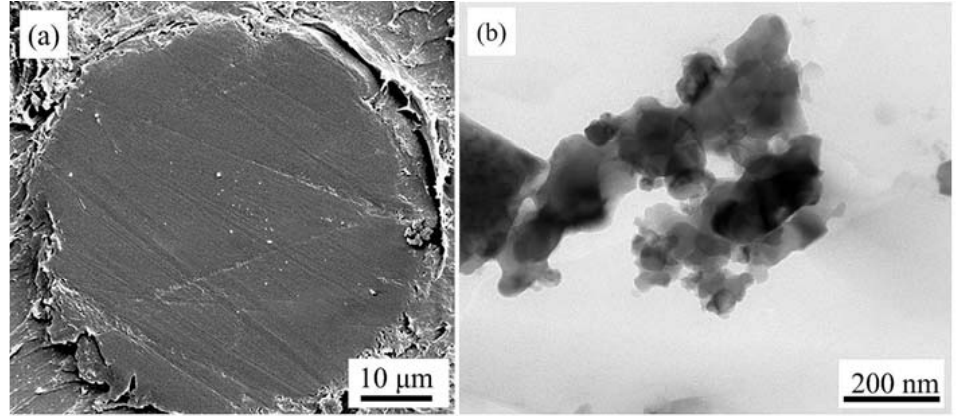
Figure 6. ( a ) Cross ‐ section image of a flame spheroidized mullite, ( b ) TEM image of flame spheroi ‐ dized powders.